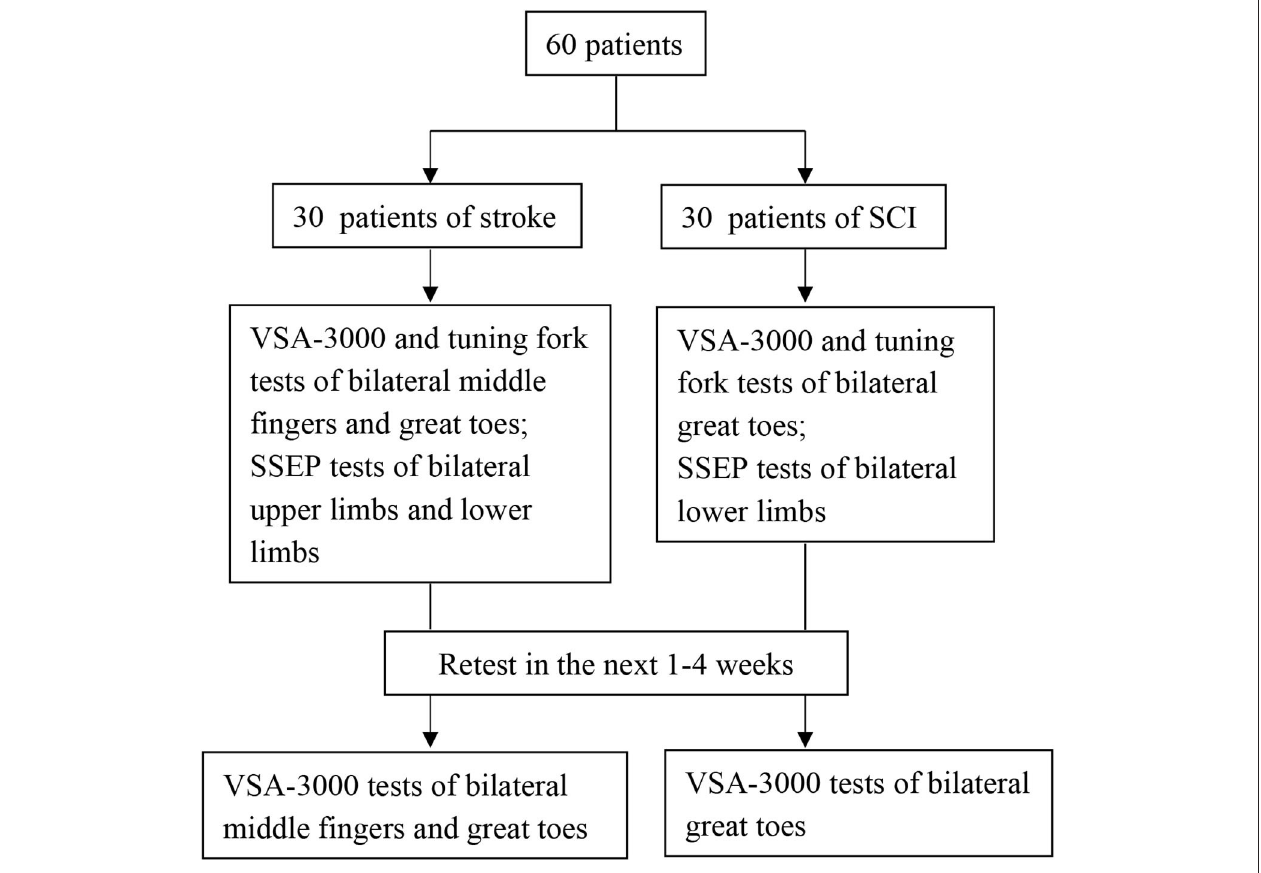
FIGURE 3 | Flow chart of the sequential